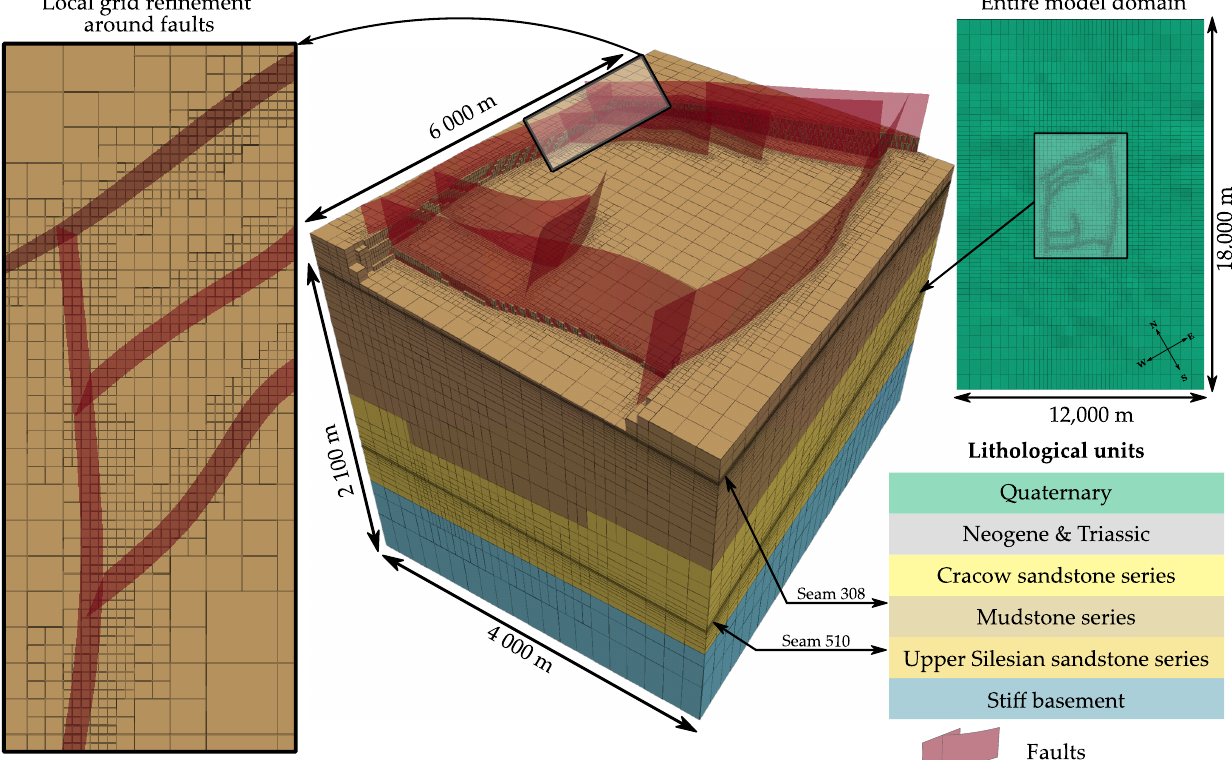
Figure 3. Numerical model of the potential storage site. The entire model domain has the three-fold size of the tectonic block to avoid mechanical impacts on the lateral model boundary conditions. The thickness of all layers, aside from the coal seams, varies within the model as a result of the varying dip directions and angles of the lithostratigraphic top